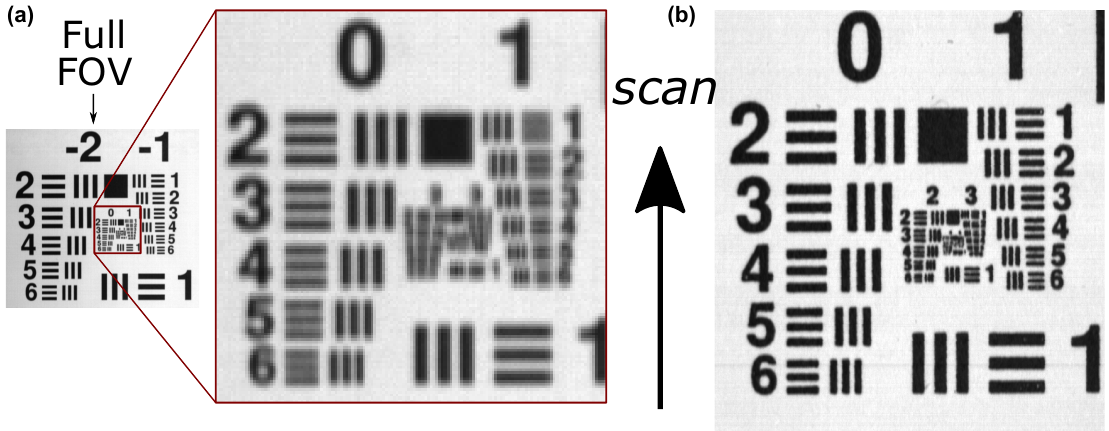
Figure 5. Resolving power test for custom-made laboratory hyperspectral imaging (HSI) system employing a USAF1951 resolution chart. ( a ) The image recorded by a 17 mm lens with magnified region that corresponds to FOV of a 50 mm objective lens; ( b ) the same image recorded by a 50 mm lens. Scanning direction is marked with an arrow; the hyperspectral images were taken by the full LED illumination; the presented images correspond to the spectral band at 500 nm.